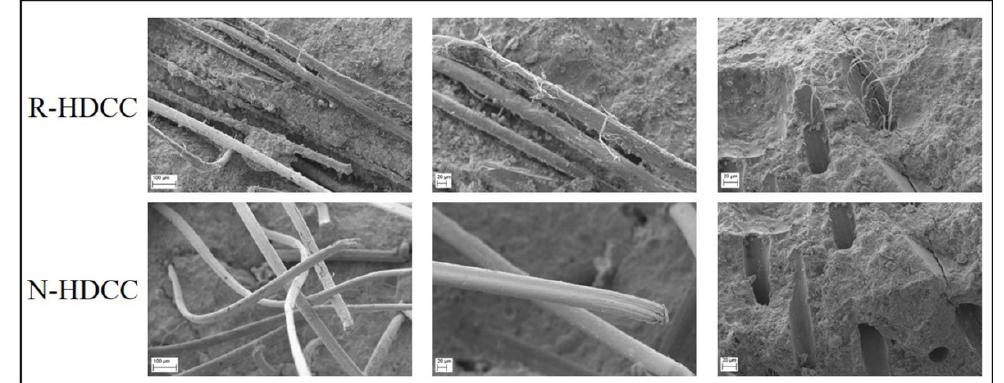
Figure 16. SEM images of fiber / matrix interface after tensile test.